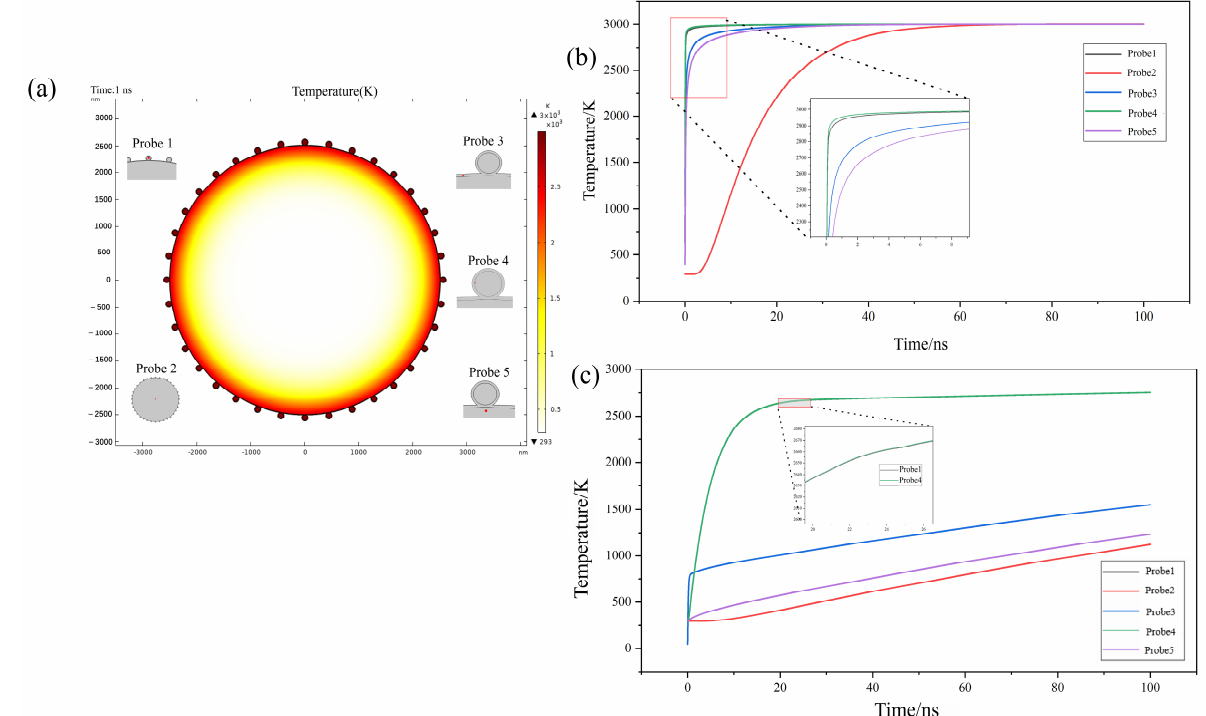
Figure 11. The temperature rise in the micro-nano composite aluminum powder ( a ), the result covered with alumina ( b ), and that covered with fluororubber ( c ). The system temperature was 4000 K (T 0 ), the diameter of the micron-sized aluminum powder was 5 μ m, and the diameter of the nano aluminum powder was 100 nm. the re- action degree is described by Equations (11) and (12).